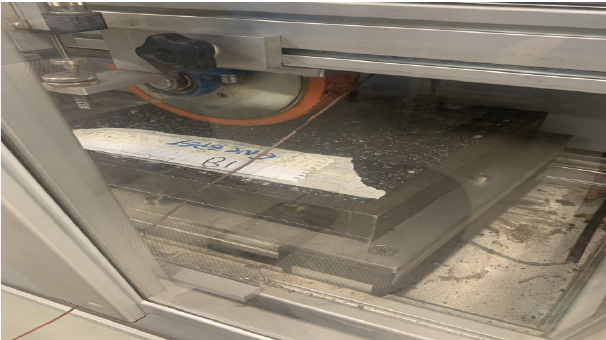
Figure 3. Wheel-tracking sample and testing at Curtin University.